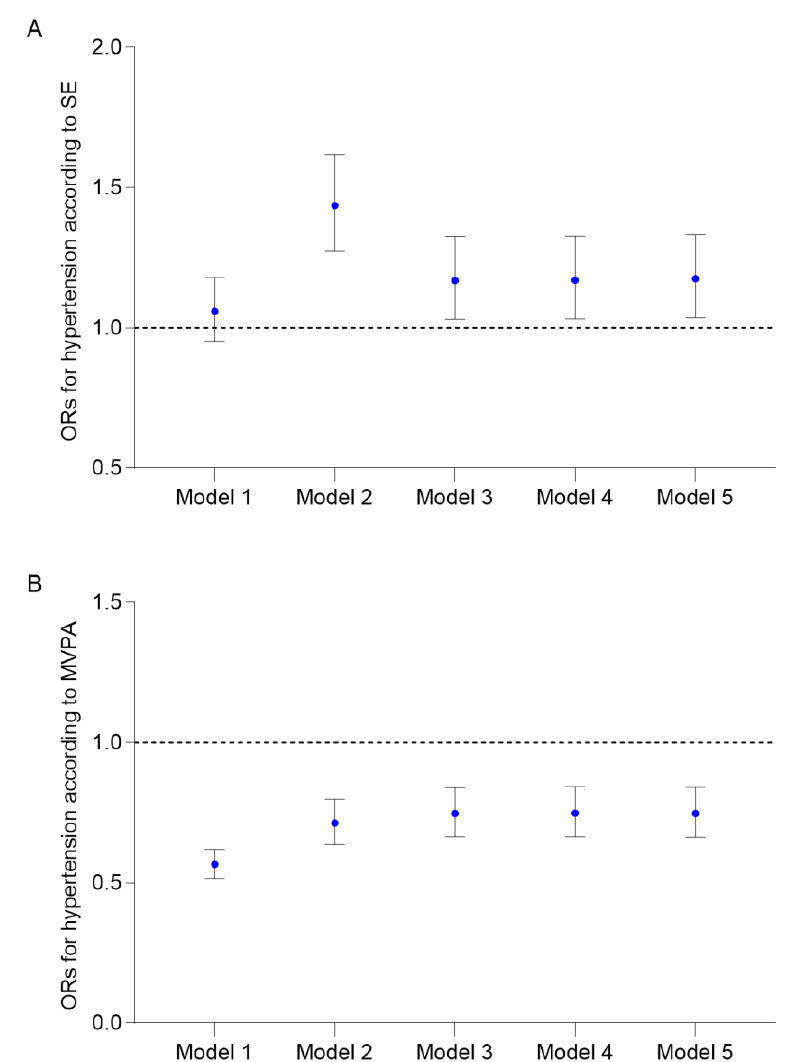
Figure 2. ORs for hypertension according to ( A ) SE ( n = 14,456), ( B ) MVPA ( n = 14,456). Model 1: crude model. Model 2: adjusted for age and sex. Model 3: adjusted for age, sex, race, education level, marital status, and family PIR. Model 4: adjusted for age, sex, race, education level, marital status, family PIR, and survey wave. Model 5: adjusted for age, sex, race, education level, marital status, family PIR, survey wave, and another exposure assessment. Abbreviations: ORs, odds ratios; other abbreviations as in Table 1.